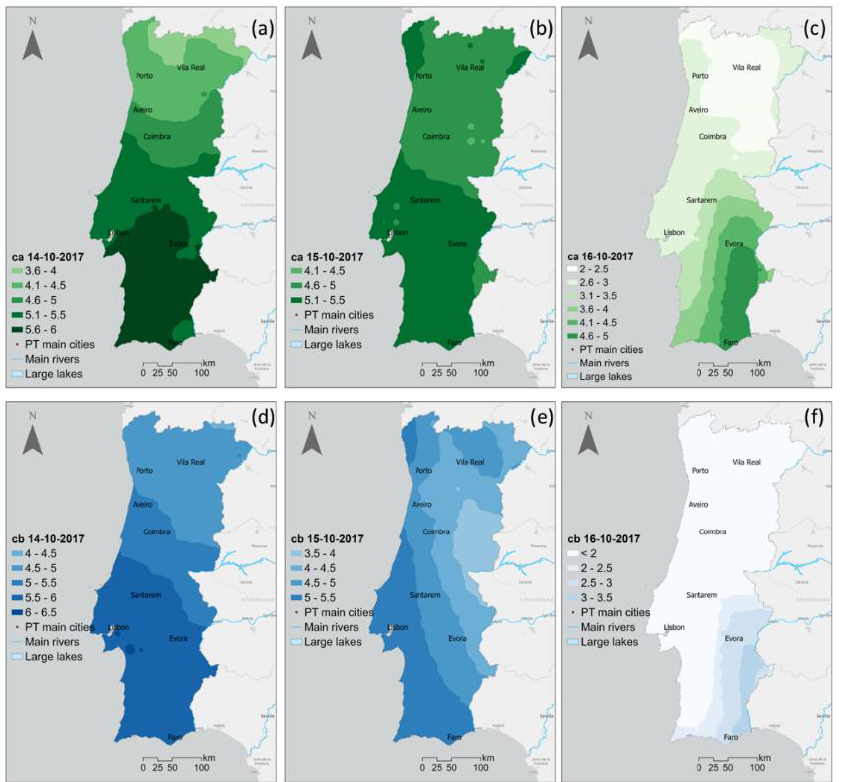
Figure A8. Daily mean values for ( a , d ) 14, ( b , c ) 15, and ( c , f ) 16 October 2017, for ca (upper row) and cb (lower row) (Note that ca was attained by (1) and cb by (2), Section 2.2.2 for further details).